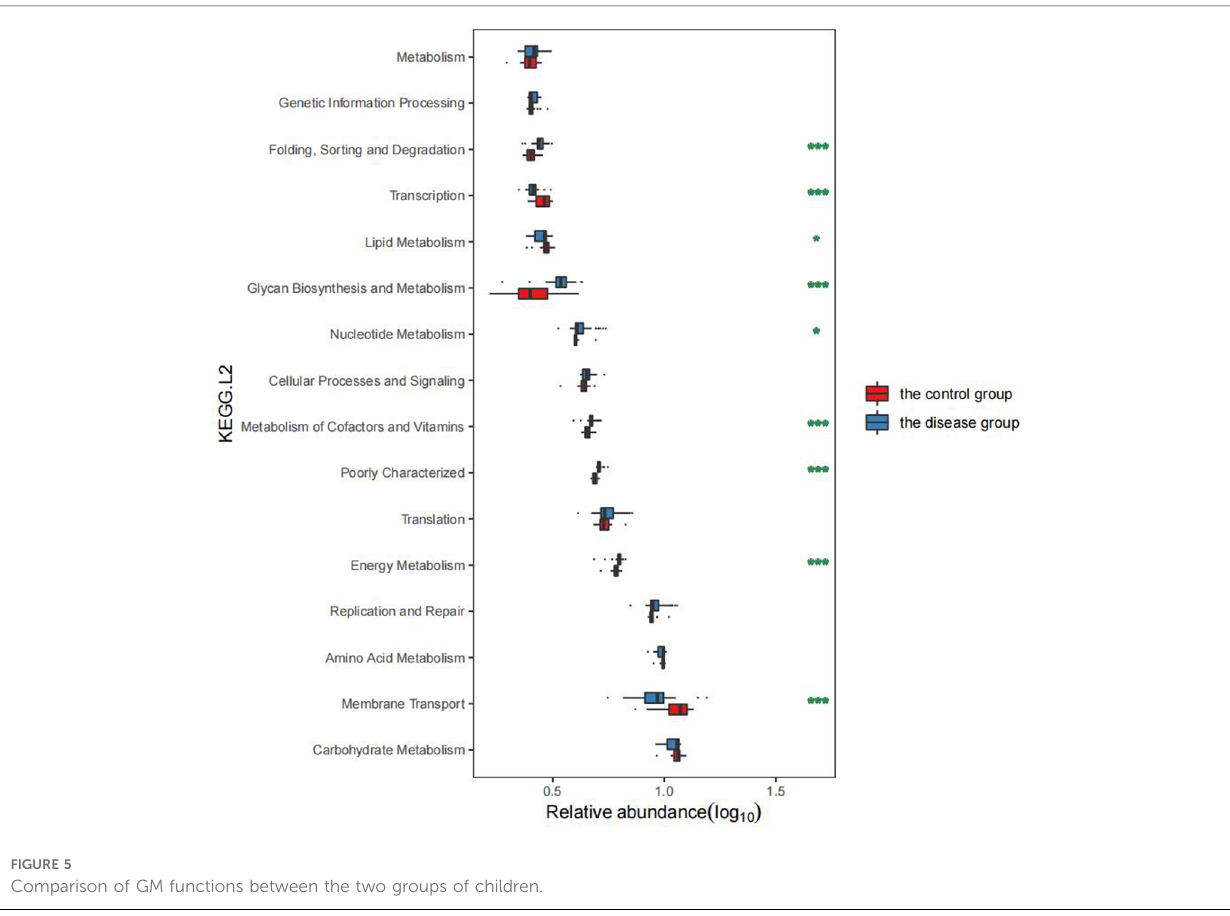
FIGURE 5 Comparison of GM functions between the two groups of